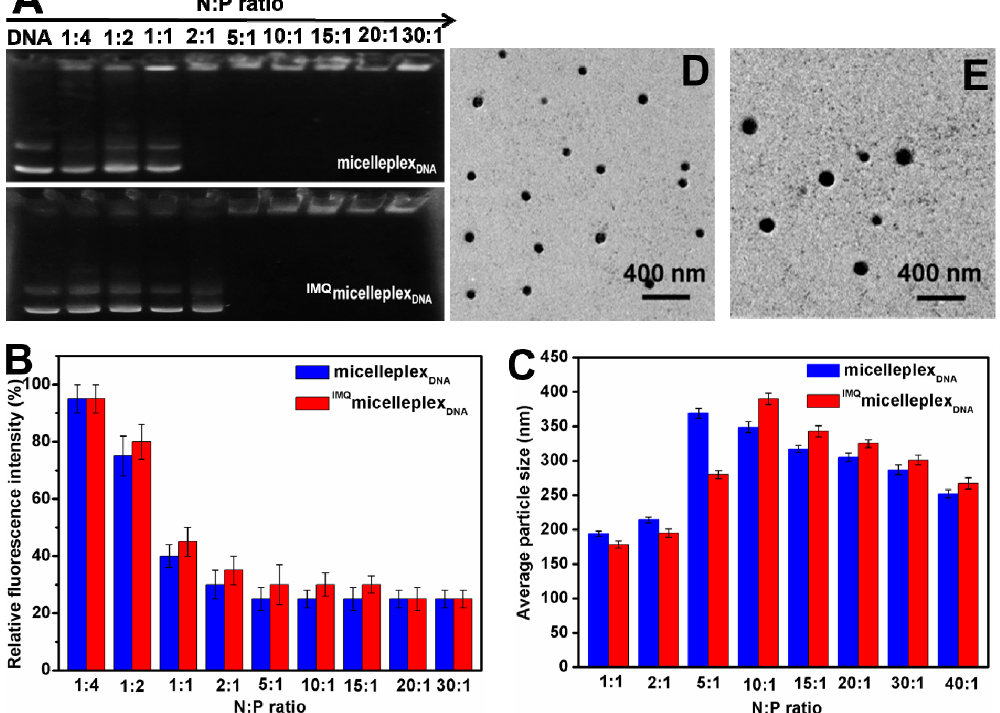
Figure 7. DNA binding, condensation by micelles, and size and morphology of micelleplexes with or without loading of IMQ. ( A ) Gel retardation assay; ( B ) ethidium bromide (EB) exclusion; ( C ) average particle size by DLS; TEM images of blank micelleplexes ( D ); and IMQ-loaded micelleplexes ( E ) at N:P = 20 (The discrete and spherical blackspots represented corresponding micelleplexes).